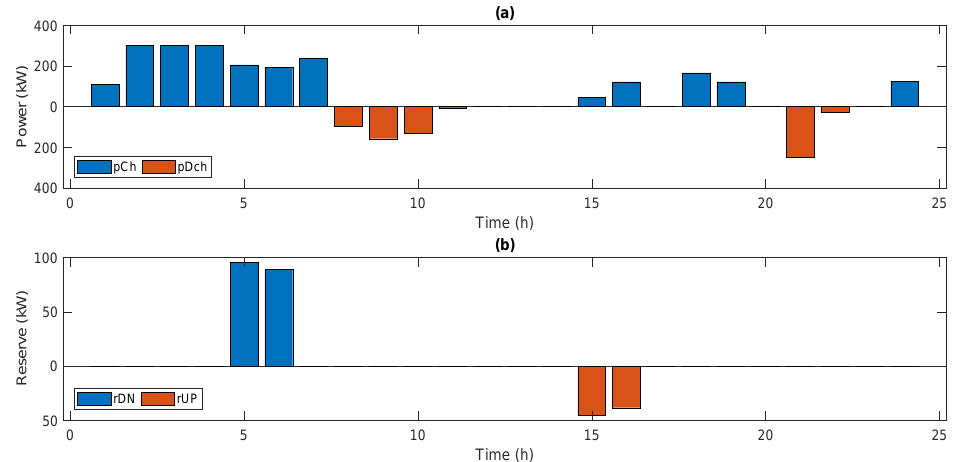
Figure 5. Power and reserve results with modified reserve prices: ( a ) Charging and discharging power; ( b ) downward and upward